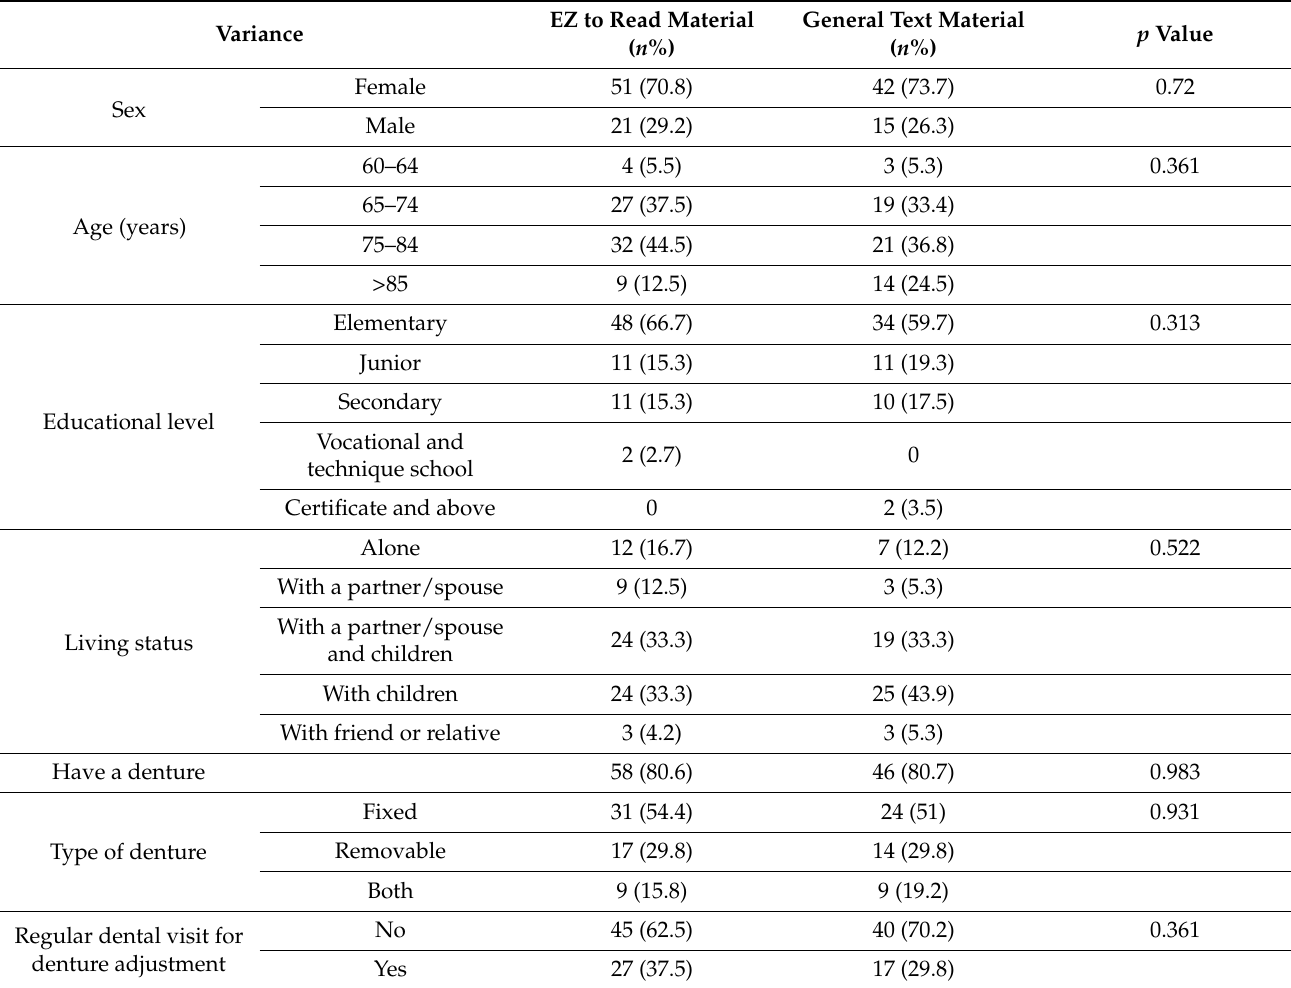
Table 1. Demographic data of the participants in each